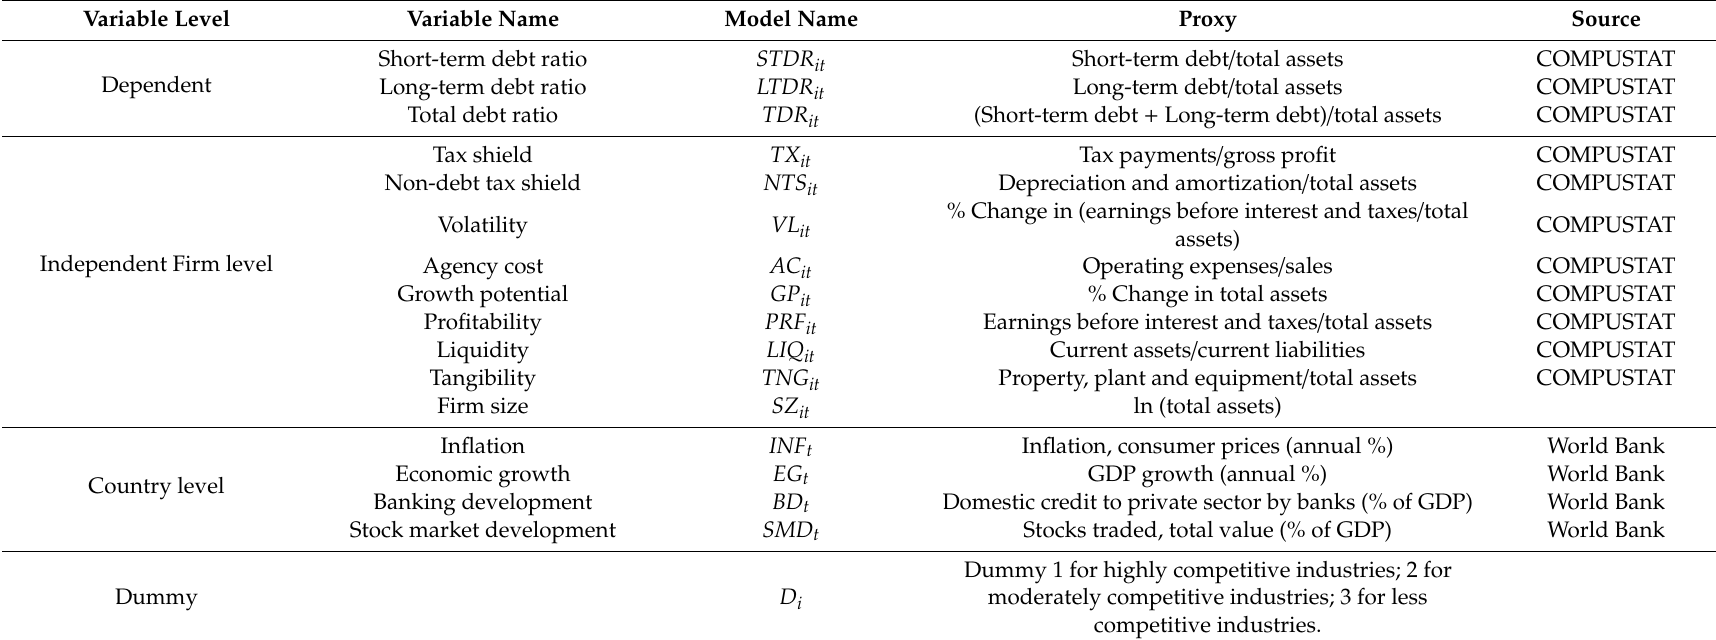
Table 1. Dependent and independent variables, their model names, and